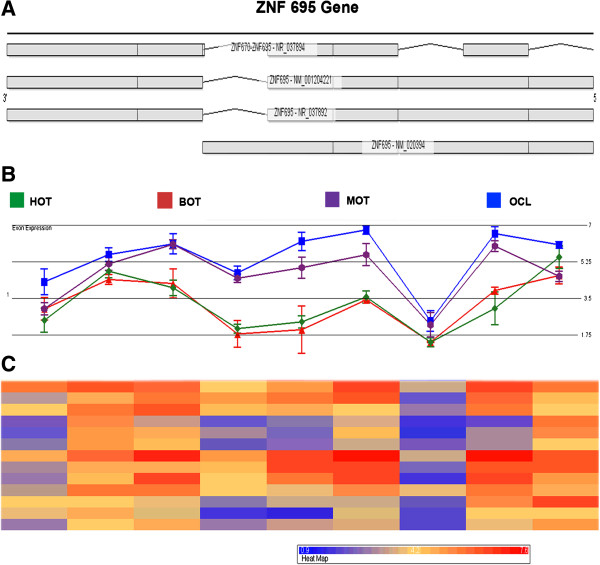
Differential ZNF695 exon usage in ovarian cancer. A) All possible splice variants of zinc finger protein (ZNF) 655 mRNAs retrieved from UCSC Genome Browser. B) Graphic depicting levels of individual exon expression in healthy ovarian tissue (HOT, green), benign ovarian tissue (BOT, red), malignant ovarian tumours (MOT, purple) and ovarian cancer cell lines (OCL, blue). C) Heat map of each of the peaks containing the individual samples.